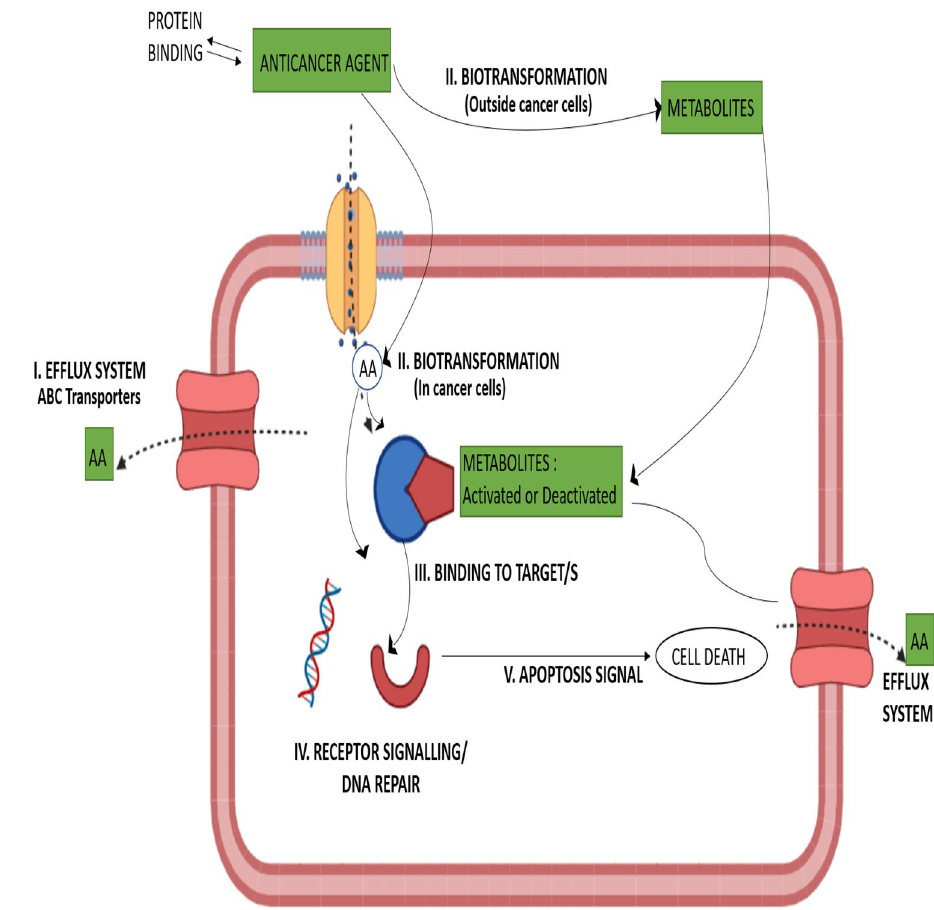
Fig. 2 The body or cancer cells (a) may develop and exhibit key anticancer drug (AA) resistance